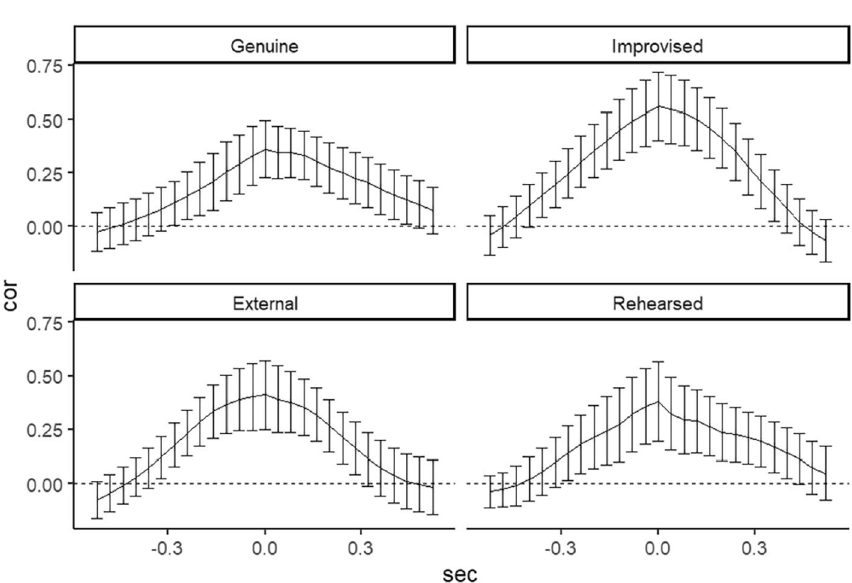
Figure 6. The cross-correlations between the right eyebrow and right eyelid for the four conditions. Error bar represents 95% Confidence